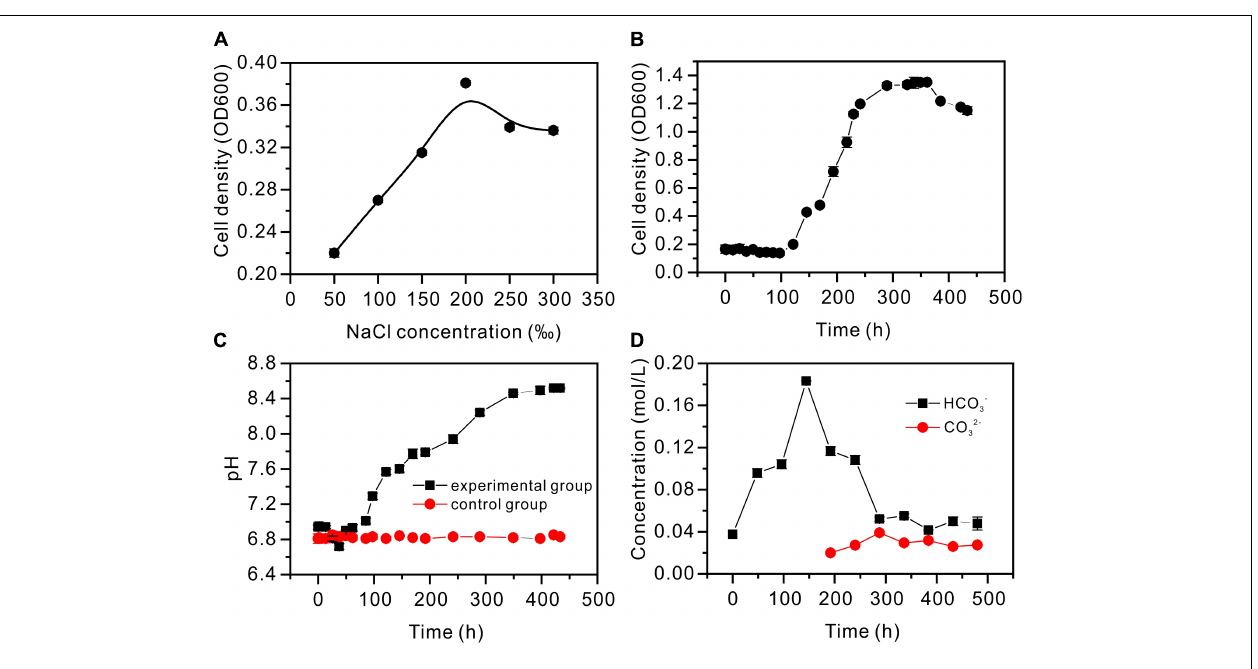
FIGURE 3 | Hydrochemical characteristics of the Vibrio harveyi QPL2 seed liquid without the addition of Ca 2 + and Mg 2 + . (A) Salinity adaptation experiment; (B) cell density growth curve through time; (C) pH curves through time; and (D) the changes in HCO 3 - and CO 32 - concentrations through